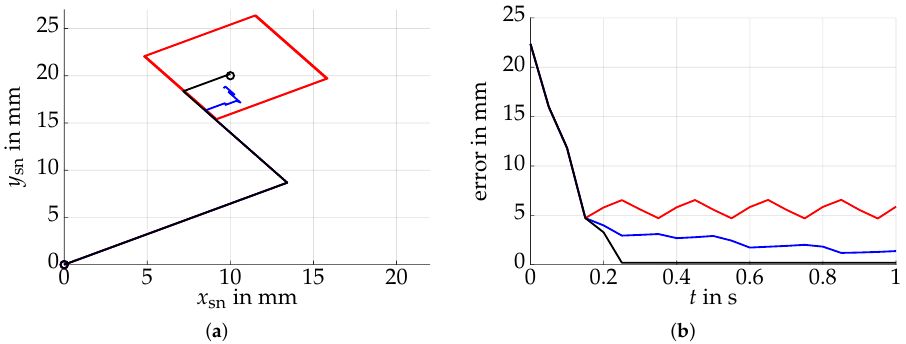
Figure 14. The basic (red), extended (blue), and pre-learned extended (black) controllers are now applied to the same setpoint problem, but the kick directions do not coincide with those of the ideal model ( a ) The basic controller now oscillates in two dimensions, while the extended controllers quickly adapt to the new kick directions. ( b ) The error decreases slower than in case of the ideal model for all controllers, but a similar number of steps is needed for the extended controllers to converge to the desired